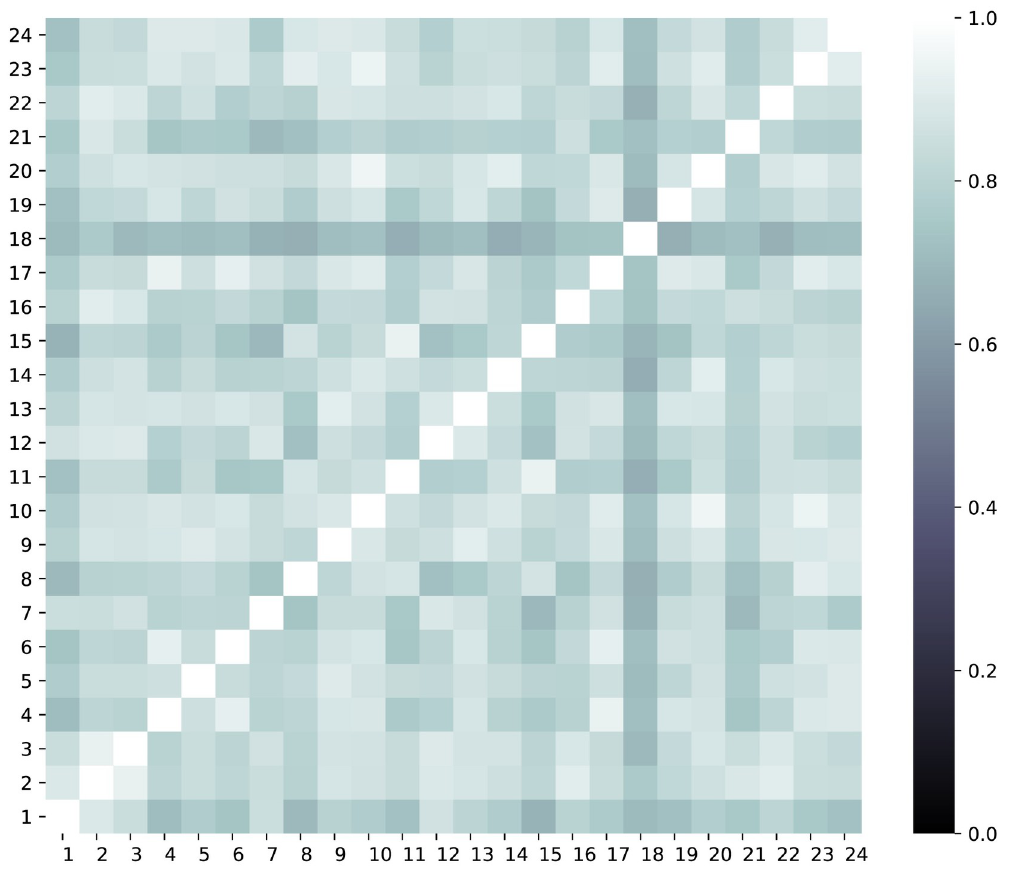
Fig 2. Heatmap showing spatial correlations of the 24 air quality monitoring